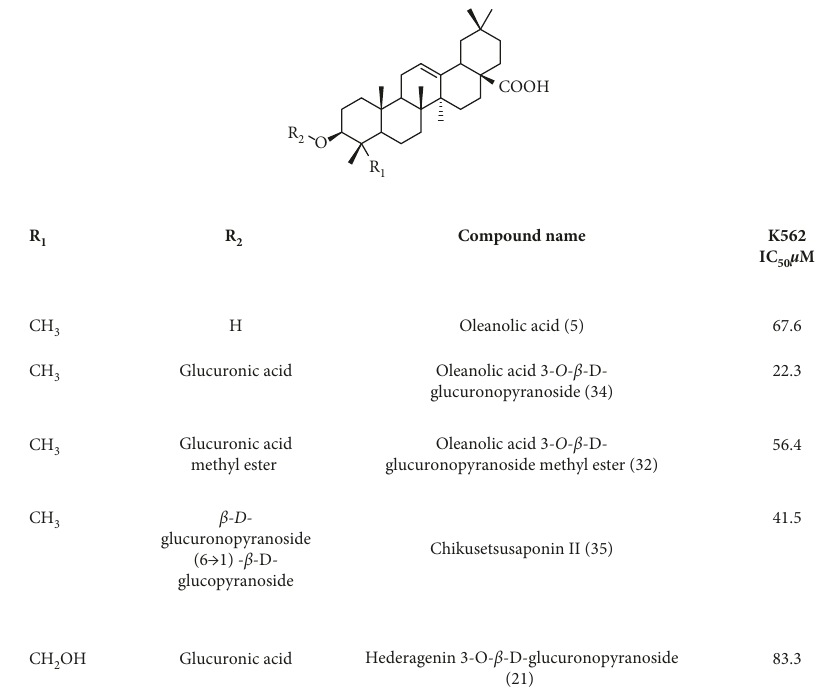
Figure 9: Antileukemic activities of different types of oleane triterpenes isolated from SS